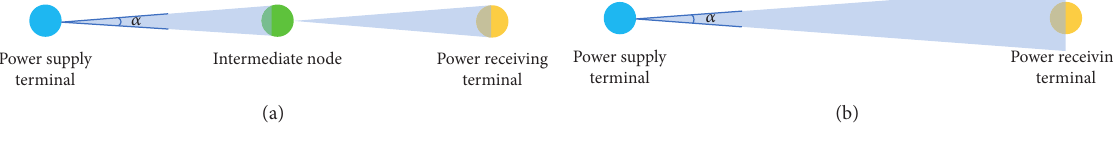
Figure 1: Comparison of the geometric attenuation of microwave wireless energy